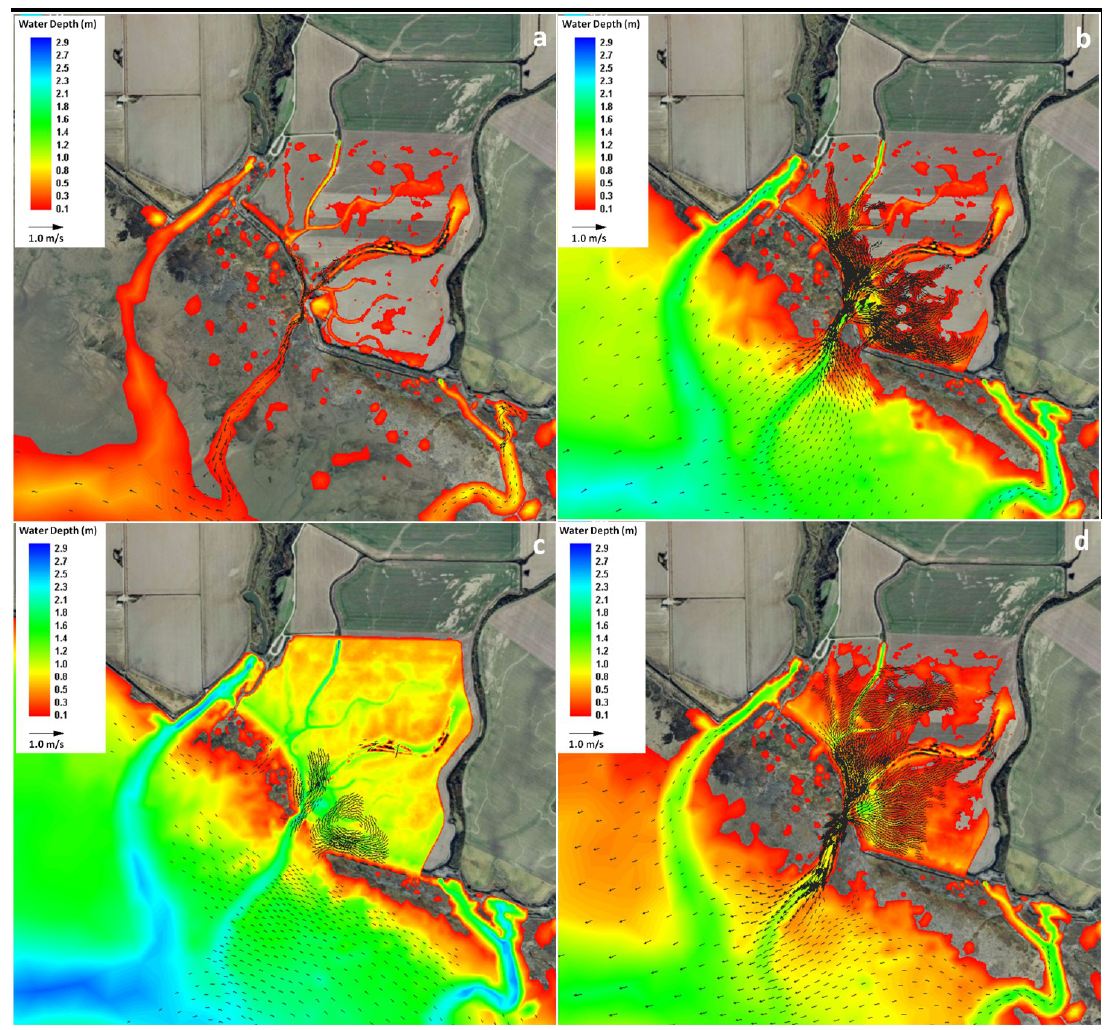
Figure 6. Instantaneous water depth and depth-averaged velocity at low tide ( a ); flood tide ( b ); high tide ( c ); and ebb tide ( d ) under preferred restoration